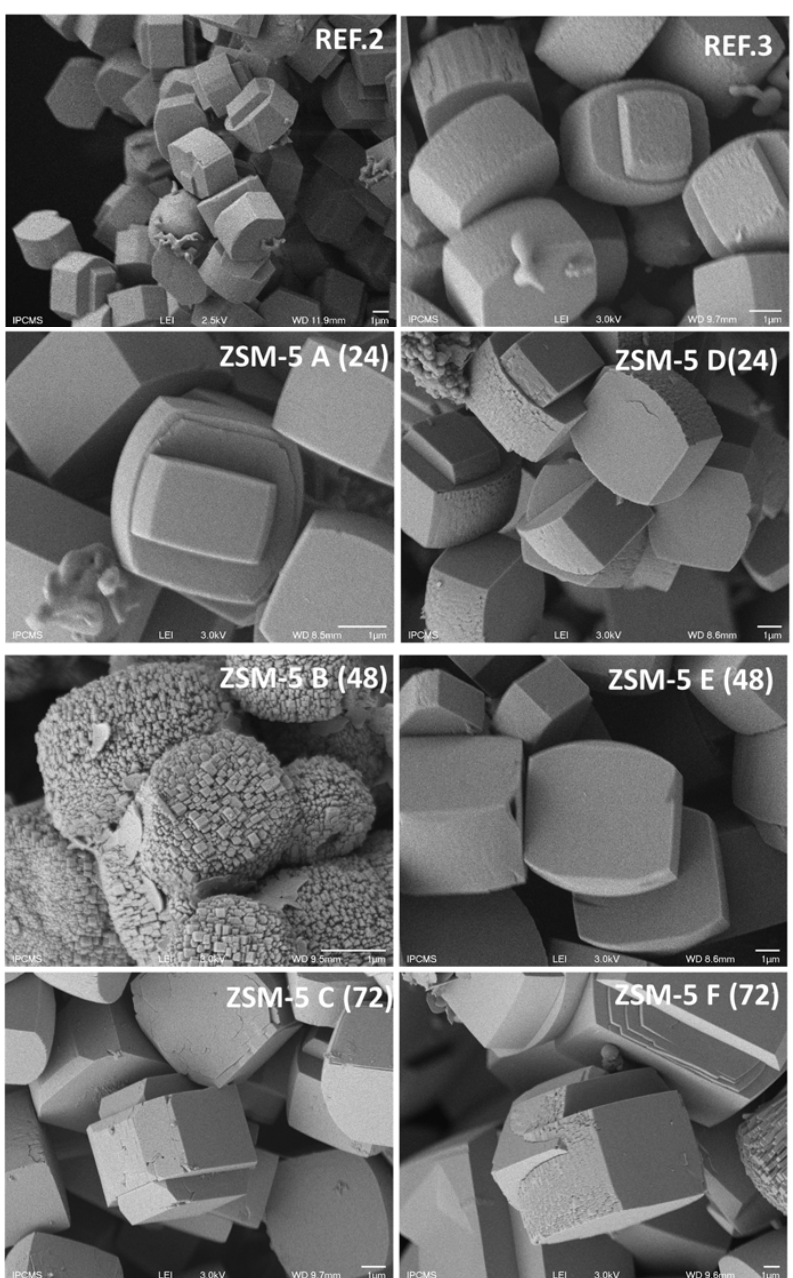
Figure 2 : SEM images (1 μ m scale ‐ bar) of zeolites synthesized for different durations. Figure 2. SEM images (1 µ m scale-bar) of zeolites synthesized for different